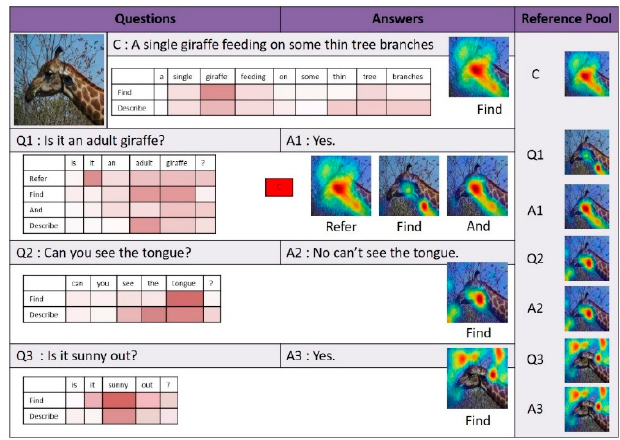
Figure 12. Dialog example 3 derived by the proposed model.